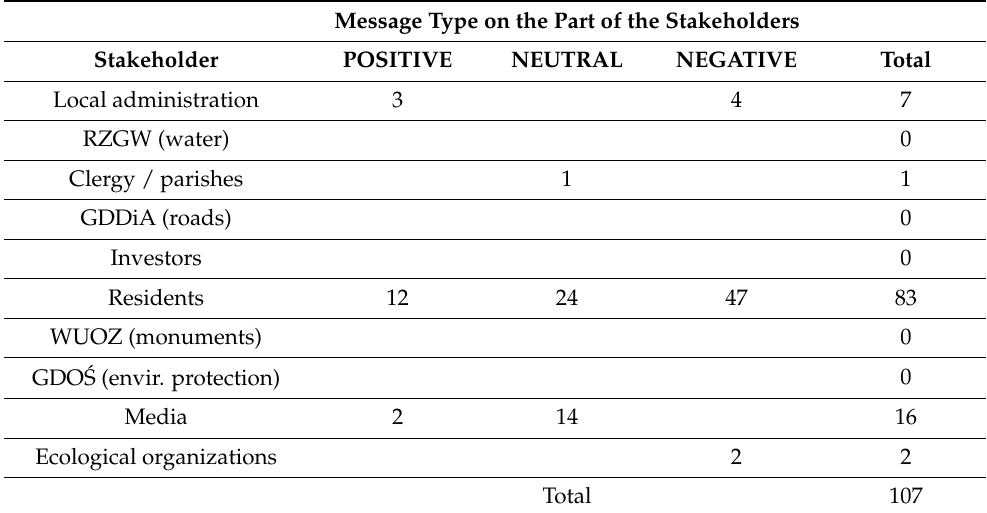
Table 4. The analysis of media messages concerning the Cyc ó w LW Bogdanka mining area. Message Type on the Part of the Stakeholders